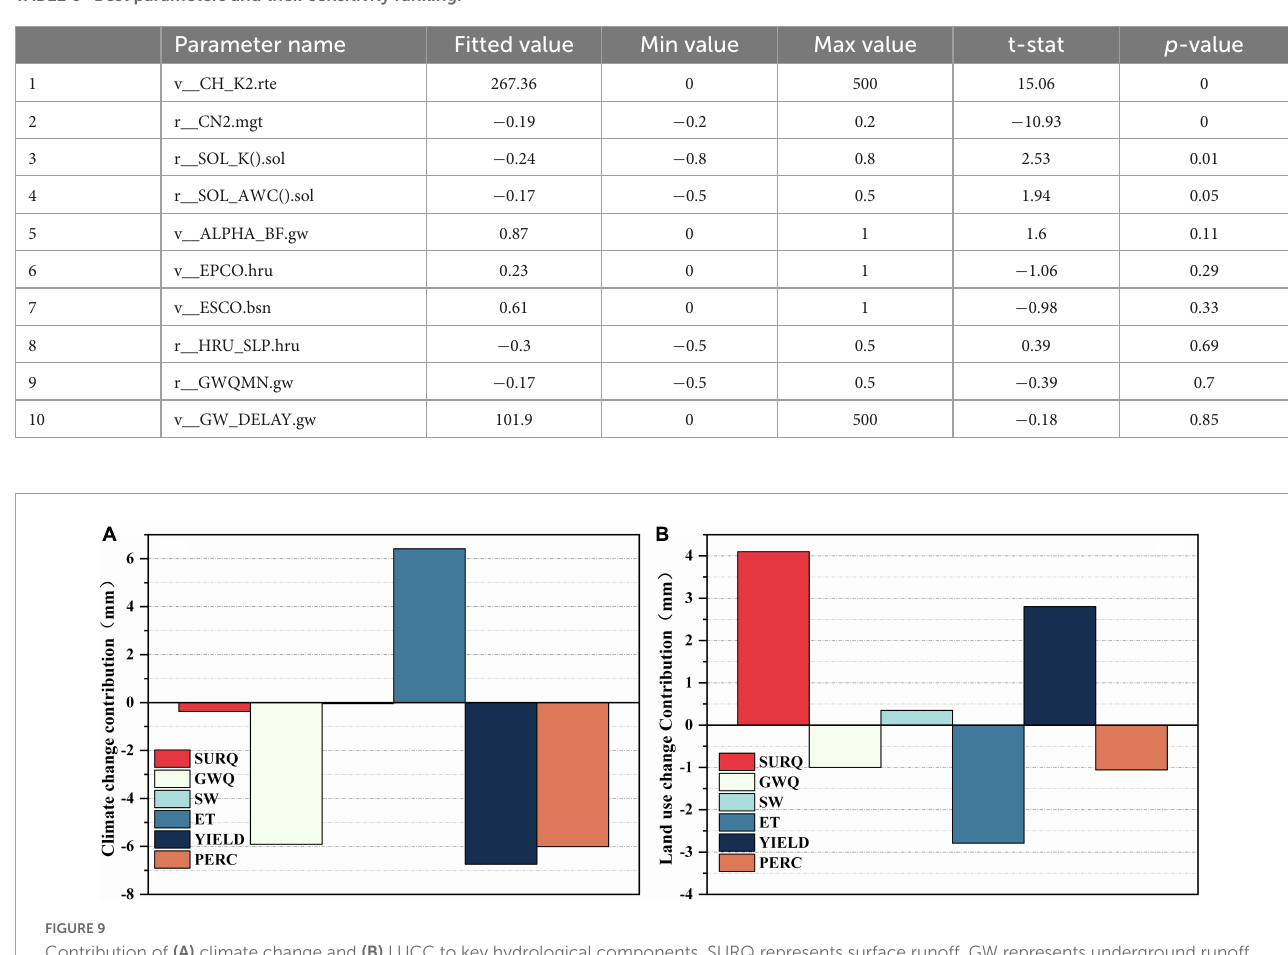
whole basin. Downstream (sub-basins 5 and 8), water yield, surface runoff, soil water, and evapotranspiration had a consistent response direction with the whole basin. However, underground runoff